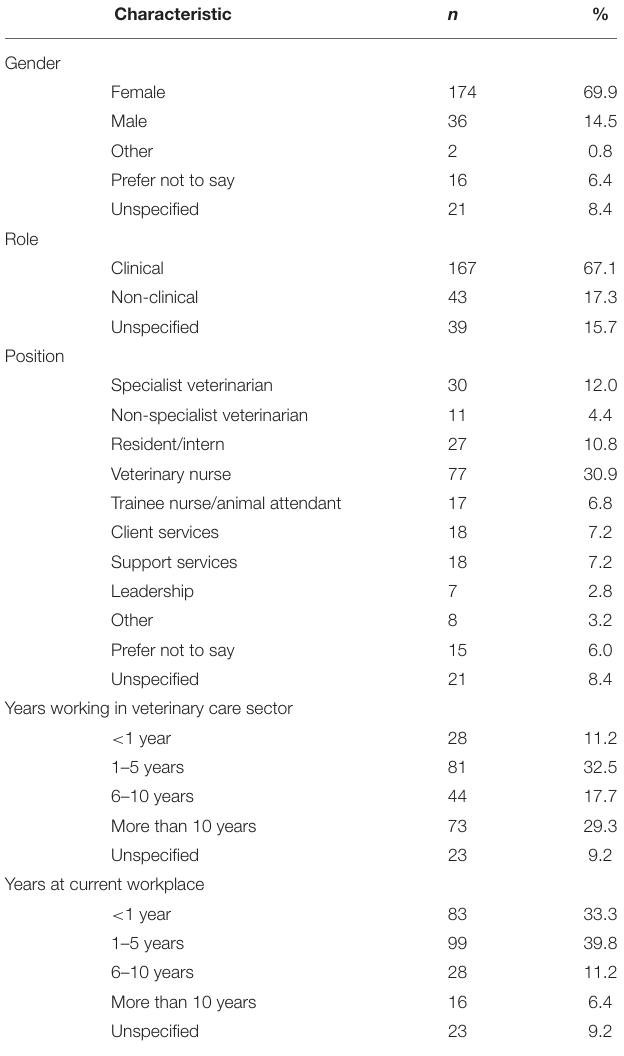
TABLE 1 | Participant characteristics ( N =